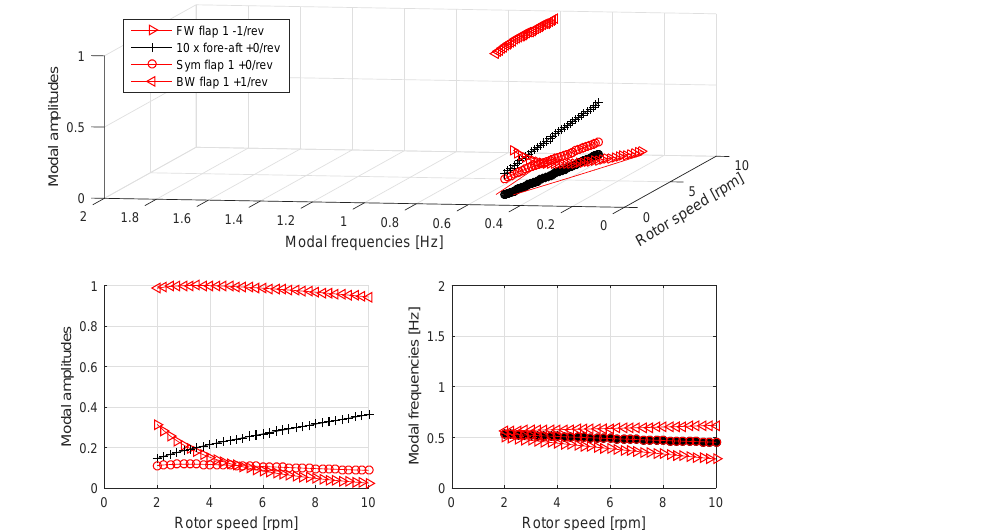
Figure 7. Harmonic modal components for the three-bladed turbine mode dominated by backward whirling (BW) of the rotor in the first flapwise DOF. Plot layout as in Fig. 5.